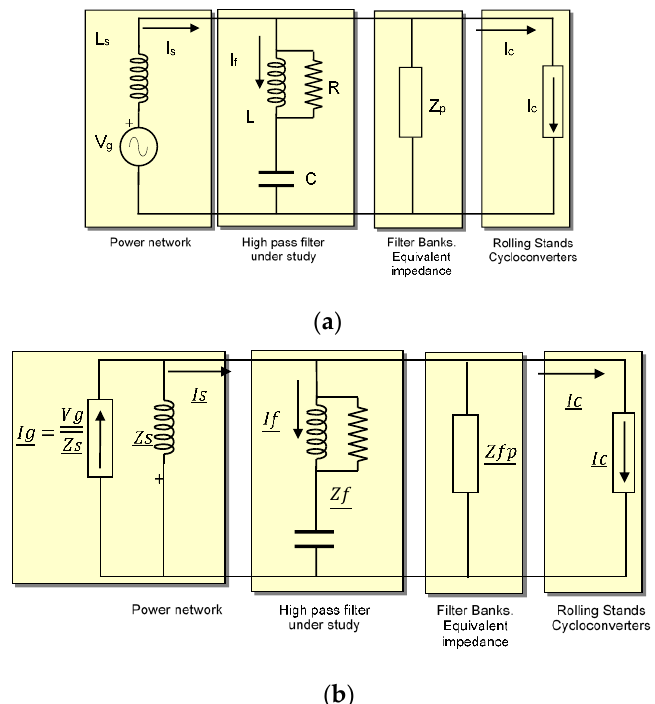
Figure 4. Electric model of the plant: ( a ) Simplified circuit model; ( b ) equivalent circuit model.